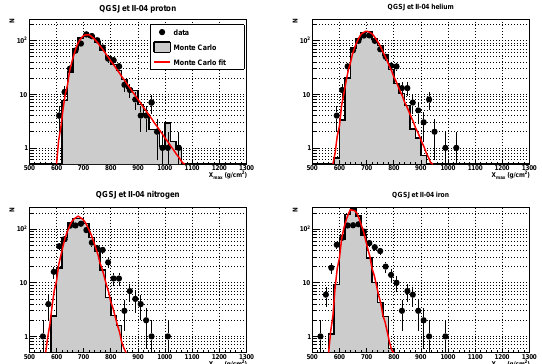
Figure 6: Comparison of BR / LR hybrid data and Monte Carlo X max distributions after systematic shifting to max- imize the likelihood function for 18 . 2 ≤ log 18 .